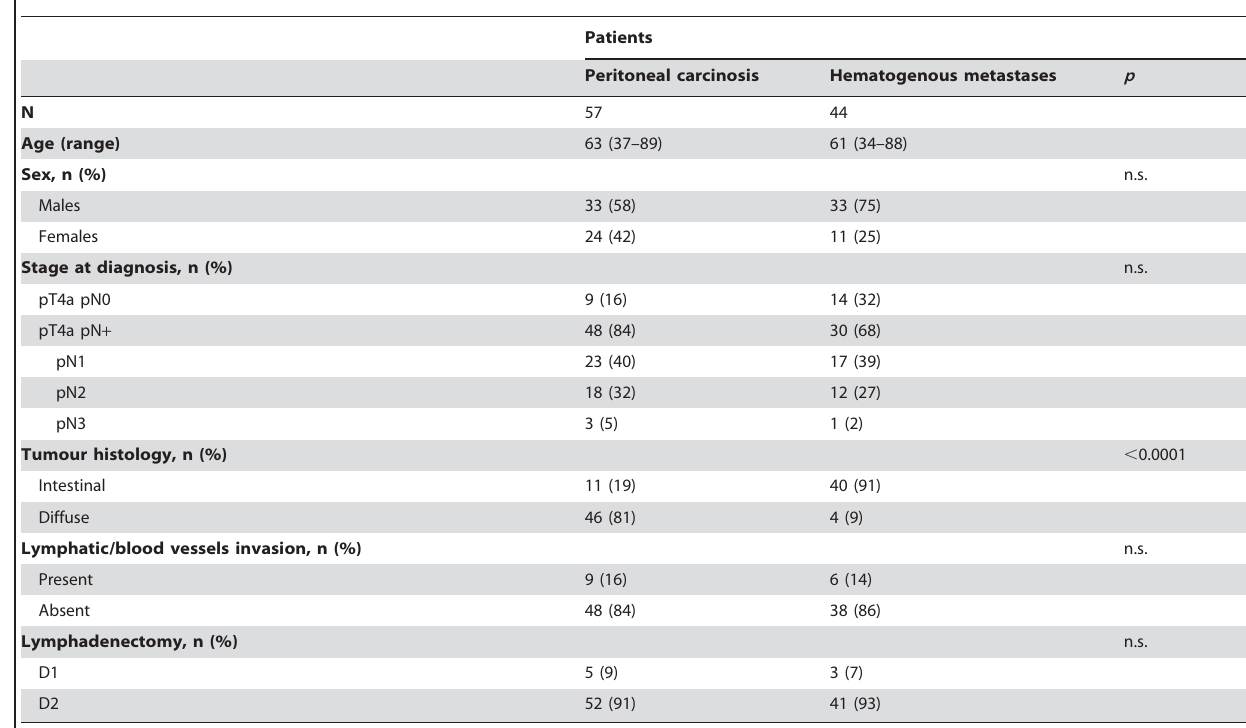
Table 2. Patients